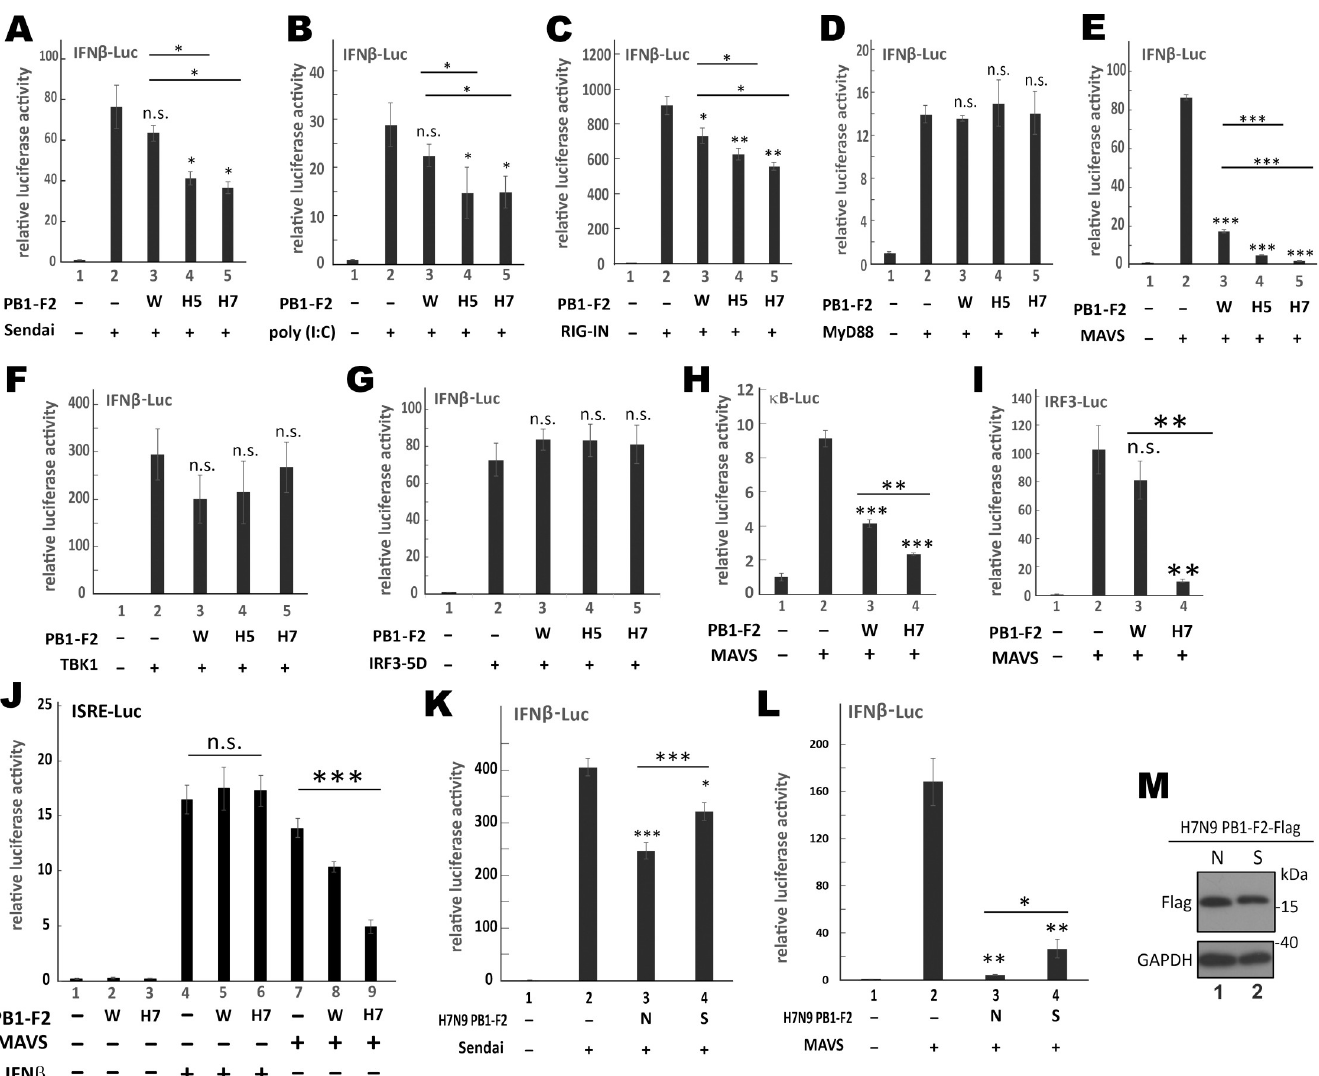
Fig 3. Suppression of RIG-I-MAVS antiviral signaling by H7N9 PB1-F2. ( A and B ) HEK293T cells in 12-well plates were transfected with 400 ng PB1-F2 expression constructs, 200 ng p125-Luc and 10 ng pRL-TK. After 24 hours, cells were treated with 100 hemagglutinating units/ml of Sendai virus (A) or 1 μ g/mL of poly (I:C) (B) for a further 16 hours. Then, cells were harvested for dual-luciferase reporter assay. ( C-G ) HEK293T cells in 24-well plates were transfected with 200 ng PB1-F2 expression constructs, 100ng p125-Luc, 10ng pRL-TK and 50ng expression constructs for type I IFN stimulants including RIG-IN (C), MyD88 (D), MAVS in pEF-Bos vector (E), TBK1 (F) or IRF3-5D (G). After 48 hours, cells were harvested for dual-luciferase reporter assay. ( H and I ) HEK293T cells in 24-well plates were transfected with 200 ng PB1-F2 expression constructs, 100 ng kB-FLuc (H) or IRF3-FLuc (I), 10 ng pRL-TK with or without 50 ng MAVS expression construct for 48 hours before harvested for dual-luciferase reporter assay. ( J ) HEK293T cells in 24-well plates were transfected with 200 ng PB1-F2 expression constructs, 50 ng MAVS expression construct, 10 ng pRL-TK plus 100ng ISRE-FLuc. After 24 hours, cells were mock-treated or treated with 1000 U/mL human recombinant IFN β protein for 24 hours before harvested for dual-luciferase reporter assay. ( K ) Same as in (A), except the inclusion of a group for H7N9 PB1-F2 S66 (S). ( L ) Same as in (E), except that 50 ng H7N9 PB1-F2 N66 (N) or S66 (S) was used. ( M ) HEK293T cells in 6-well plates were transfected with 1 μ g expression construct for H7N9 PB1-F2 with N66 (N) or S66 (S) for 48 hours before SDS-PAGE and Western blot analysis. Anti-Flag recognized PB1-F2 protein. GAPDH served as internal loading control. All bars denote means ± SD of triplicate experiments. Unpaired Student’s t-test was performed to evaluate the statistical significance of the difference between vector control (vec) and the indicated sample. ��� : P < 0.001. �� : P < 0.01. � : P < 0.05. n.s.: P >